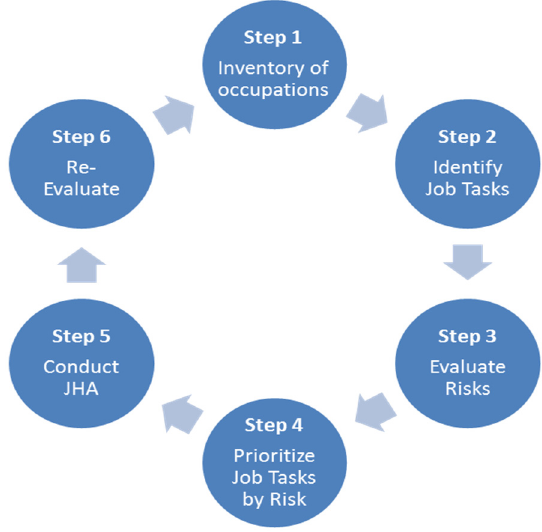
Figure 3. Process of performing a Job Safety Analysis (JSA) in industry [7].